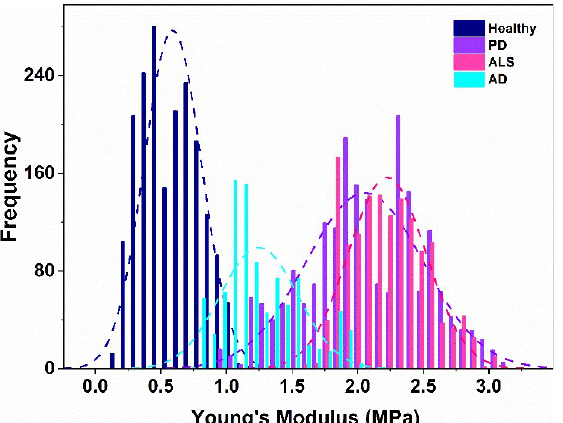
Figure 3. Histograms of the distribution of the Young’s modulus and the corresponding Gaussian distributions of the stiffness of platelets from healthy individuals (blue) and patients with AD (cyan), PD (violet) and ALS (pink).